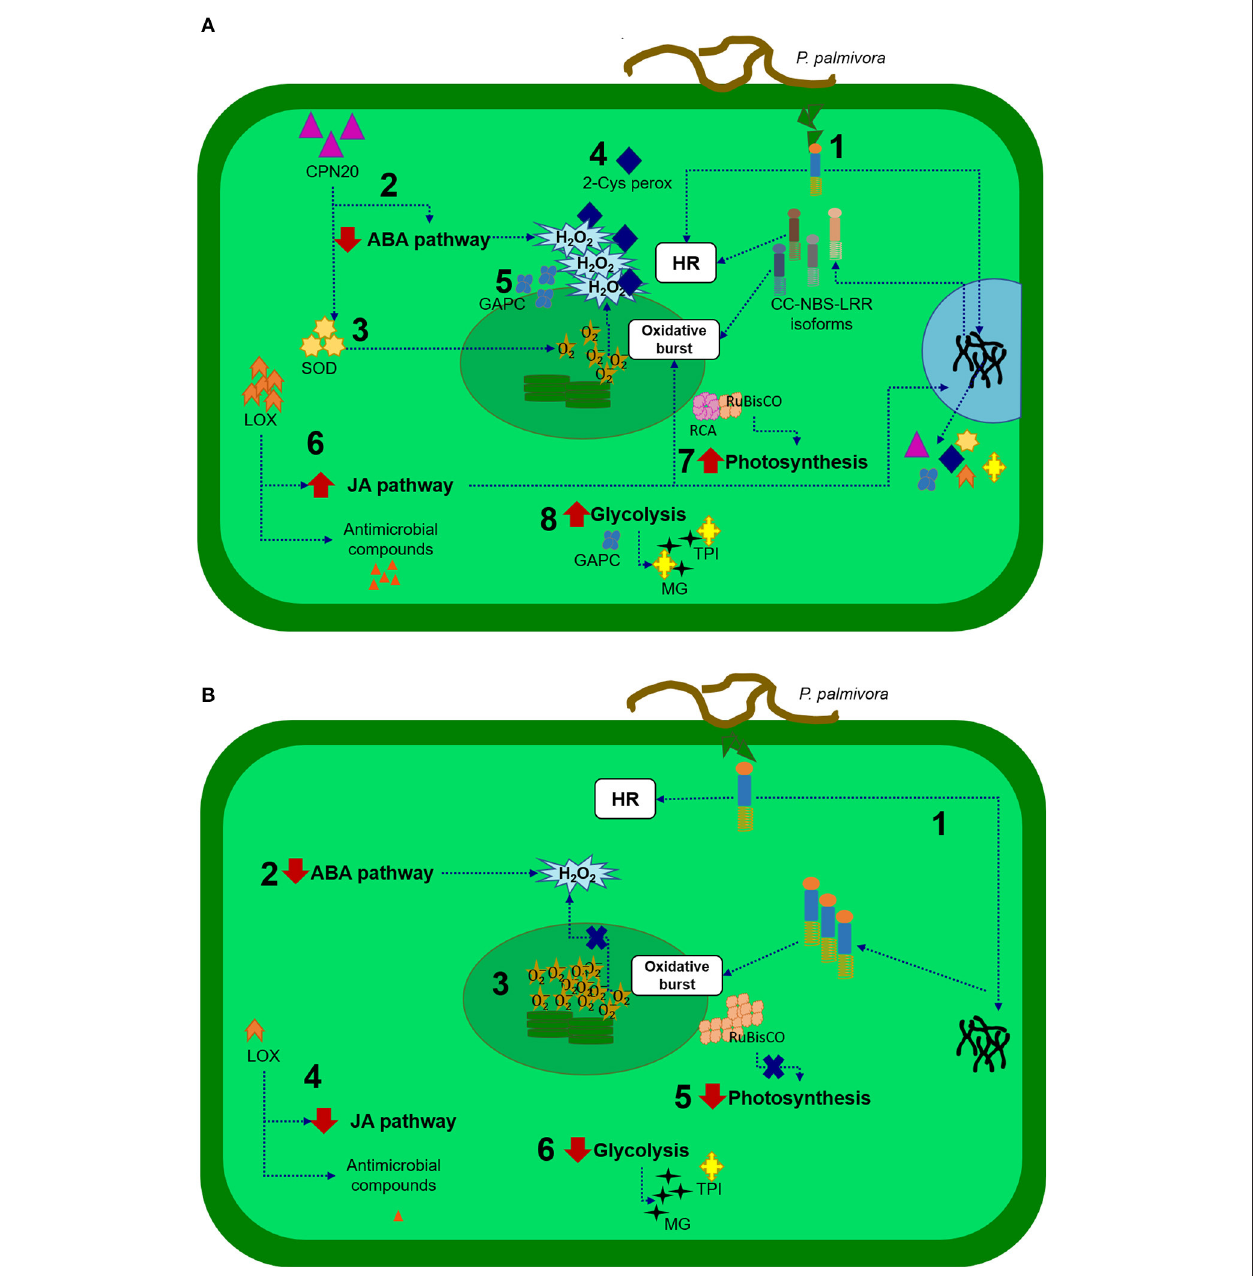
FIGURE 4 | Representative scheme of the defense responses of the cacao tree to P. palmivora . In the resistant clone (A) : (1) A CC-NBS-LRR protein recognizes products derived from the pathogen, initiating a response that includes hypersensitive response (HR) and signaling for expression of isoforms and other proteins that help in defense responses; (2) CPN20 protein negatively regulates the signaling of ABA, promoting H 2 O 2 accumulation; (3) CPN20 also activates superoxide dismutase (SOD) enzymes that dismutate superoxide in H 2 O 2 and O 2 ; (4) 2-cys peroxiredoxin regulates H 2 O 2 concentration; (5) A cytosolic glyceraldehyde-3-phosphate-dehydrogenase (GAPC) protect against redox imbalance; (6) A lipoxygenase (LOX) protein activates jasmonic acid (JA) production, which enhances superoxide production and activates genes encoding proteins involved in defense responses; (7) RuBisCO activase (RCA) is increased, assisting in the activity of RuBisCO increasing photosynthesis and (8) Active glycolysis, where the triosephosphate isomerase (TPI) enzyme assists in the control of methylglyoxal levels (MG), a cytotoxic by-product of glycolysis. In the susceptible clone (B) : (1) A CC-NBS-LRR protein recognizes products derived from the pathogen. This isoform could initiate responses like HR, but there would be no expression of other isoforms; (2) ABA pathway reduced allows the accumulation of H 2 O 2 ; (3) In CPN20, 2-Cys peroxiredoxin or GAPC accumulation could lead to imbalance redox; (4) Decrease in LOX accumulation causes a decrease in the production of jasmonic acid and antimicrobial compounds; (5) RuBisco not activated can affect photosynthesis; (6) Glycolysis pathway is reduced, and production of TPI could be insufficient to protect against cytotoxic compounds.